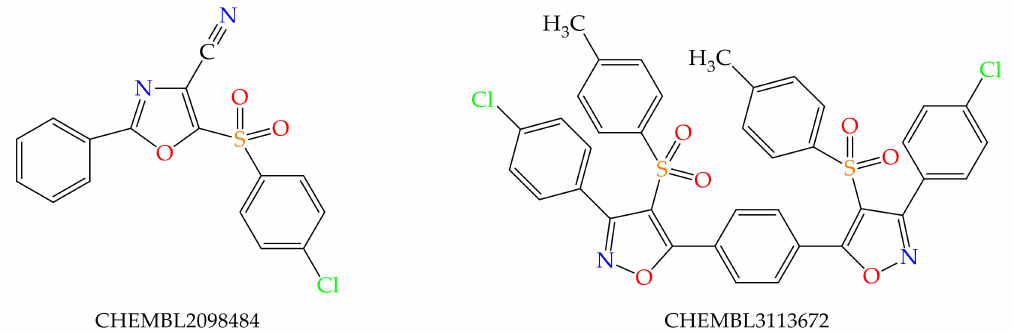
Figure 6. Structures of two compounds extracted from ChEMBL which are structurally similar to the compounds 6a and 6b